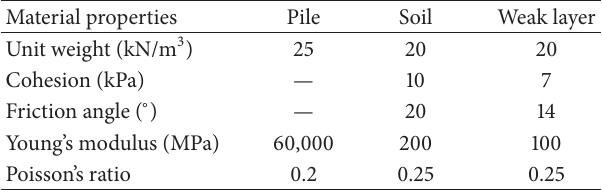
Table 1: Material